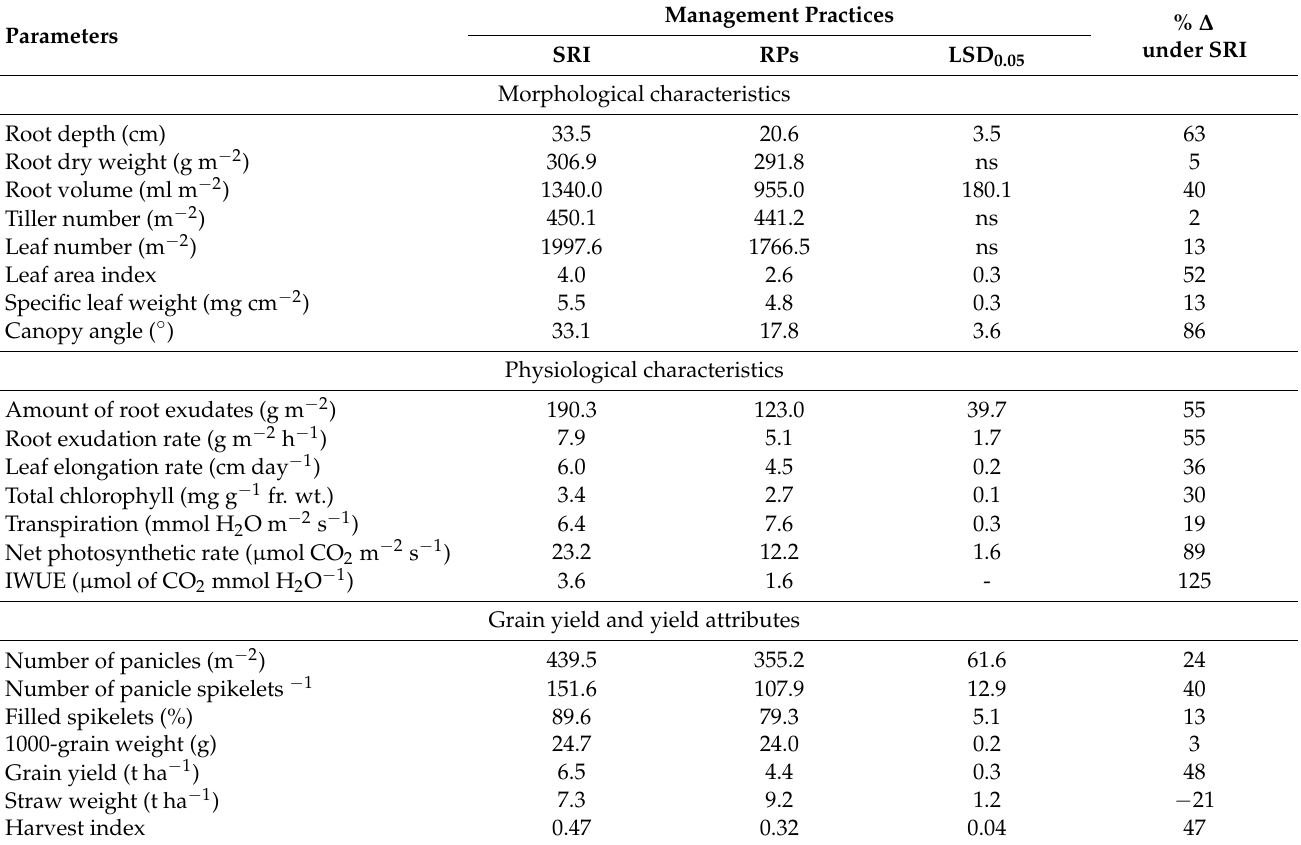
Table 2. Effects of rice management practices on morphological–physiological characteristics, grain yield, and yield attributes in